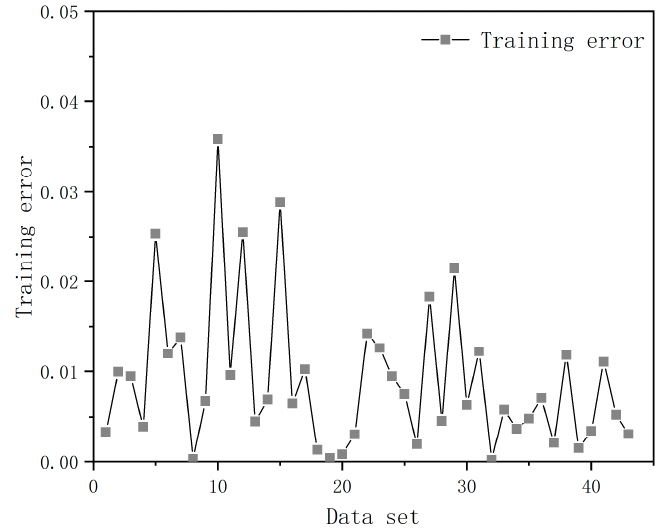
Figure 4. Training error of RBF.